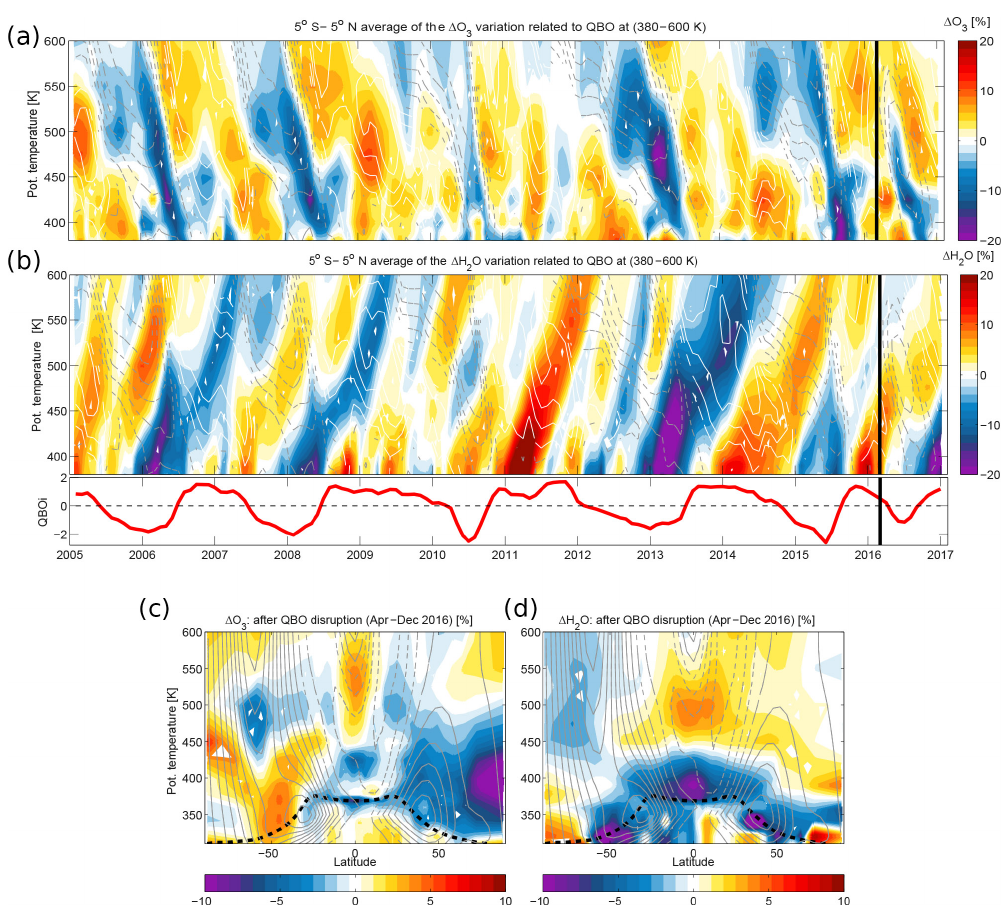
Figure 3. QBO impact on the stratospheric O 3 (a) and H 2 O (b) from MLS satellite observations for the 2005–2016 period in percent change relative to monthly mean mixing as a function of time and potential temperature. Shown QBO impact on the stratospheric trace gases is derived from the multiple regression fit as the difference between the residual ( (cid:15) in Eq. 1) without and with explicit inclusion of the QBO signal. The vertical black line indicates the QBO shift onset (February 2016). The lower panel below indicates the QBO index at 50hPa in red. Panels (c–d) show the zonal mean QBO disruption impact on stratospheric O 3 (c) and H 2 O (d) averaged from April to December 2016 in percent change relative to monthly mean mixing ratios. The black dashed horizontal line indicates the tropopause from ERA-Interim. Monthly mean zonal mean wind component, u (ms − 1 ), from ERA-Interim is overlaid as solid white (westerly) and dashed gray (easterly)